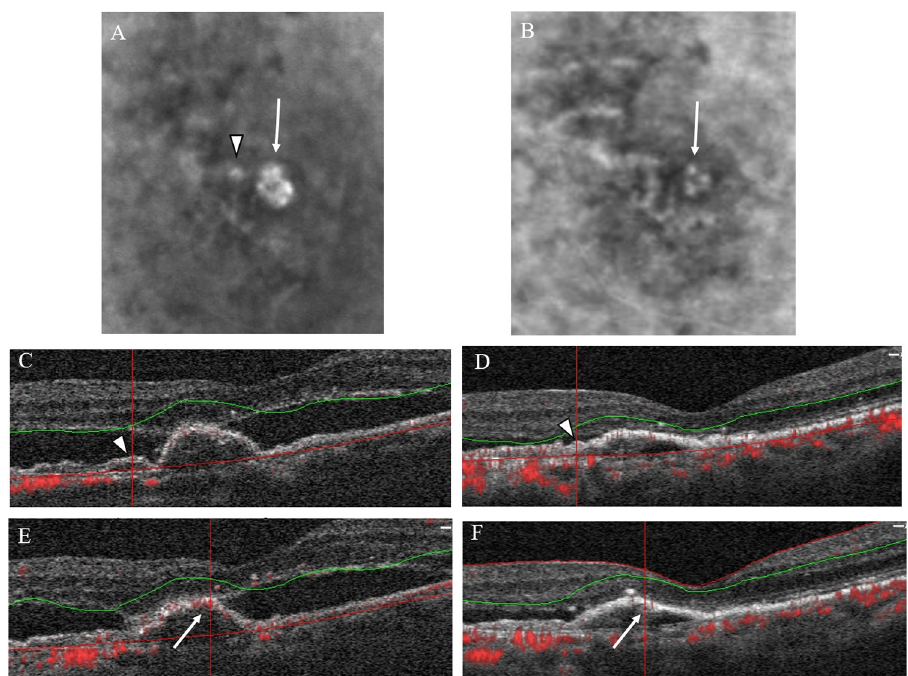
Fig 4. ICGA and OCTA of case 3. (A) ICGA before treatment showed 2 polyps, labeled as polyp 5 (arrowhead) and polyp 6 (arrow). (B) ICGA after treatment showed complete regression of polyp 5, but partial regression of polyp 6 (arrow). (C) OCTA of polyp 5 before and (D) after treatment showed the absence of flow signal (arrowhead) in this low-flow polyp. (E) OCTA of polyp 6 before treatment showed the presence of flow signal (arrow) but (F) the absence of flow signal (arrow) after treatment. Note the decrease in subretinal fluid and height of pigment epithelial detachment after treatment.